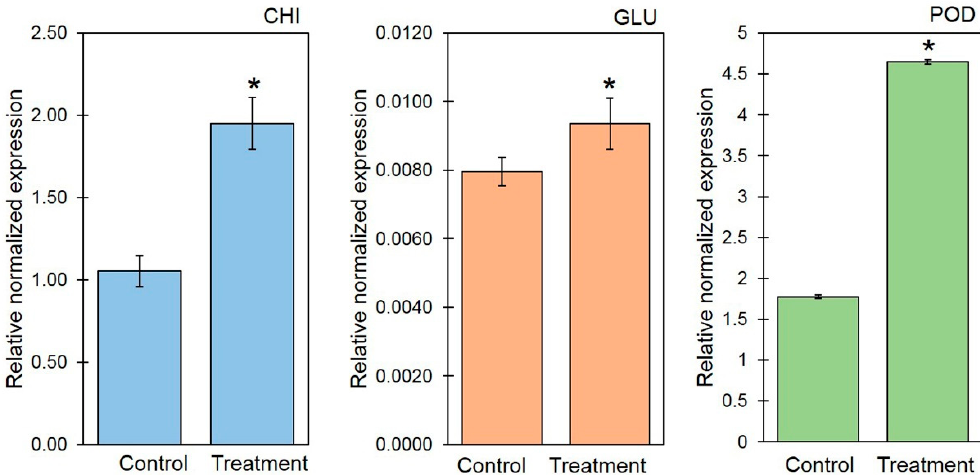
Figure 5 . Relative gene expressions of chitinase ( CHI ), β -1,3-glucanase ( GLU ), and peroxidase ( POD ) in the VOC-treated A. thaliana and control. Asterisks indicate statistically significant differences (* p < 0.05) using the Student’s t -test.